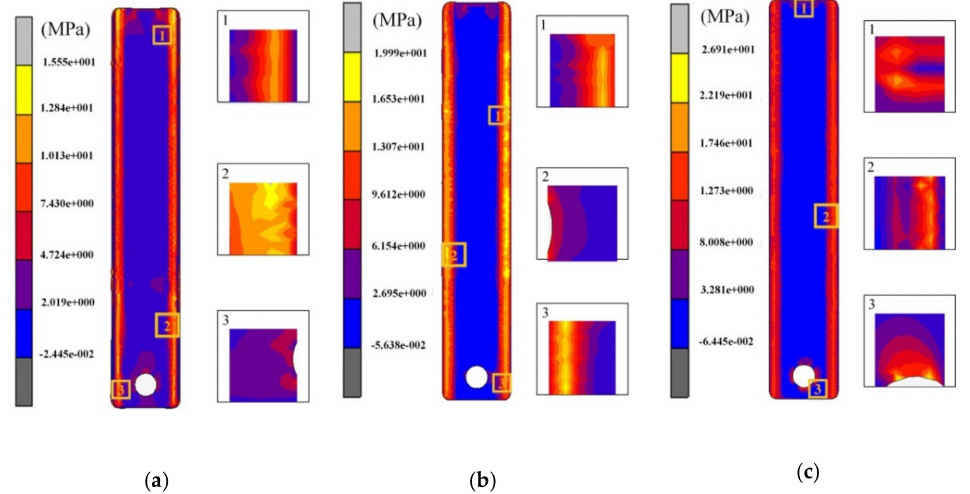
Figure 10. Residual stress results (molding temperature 610 ◦ C, 640 ◦ C, 670 ◦ C; heating rate 1.5 ◦ C/s, cooling rate 1 ◦ C/s). ( a ) The maximum residual stress is 15.5 MPa; ( b ) The maximum residual stress is 19.9 MPa; ( c ) The maximum residual stress is 26.9